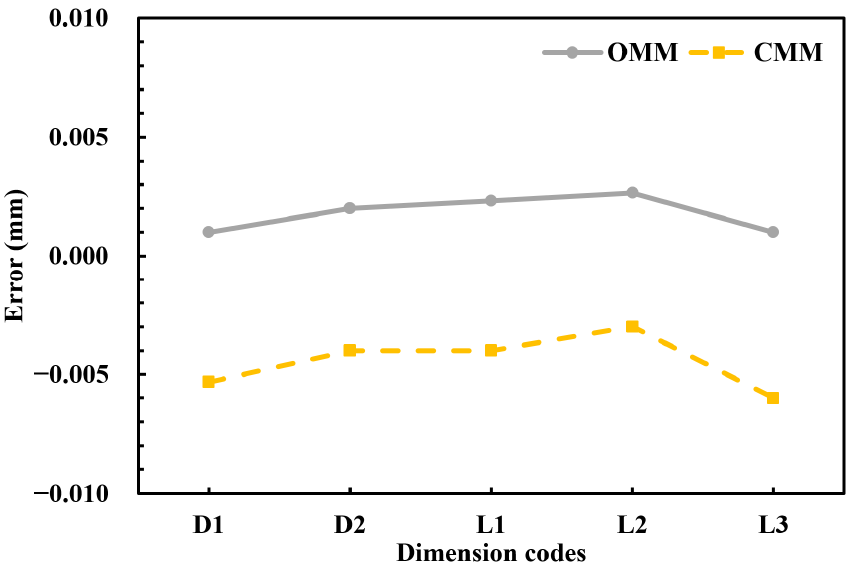
Figure 9. Comparison chart of measurement between OMM (after probe calibration) and